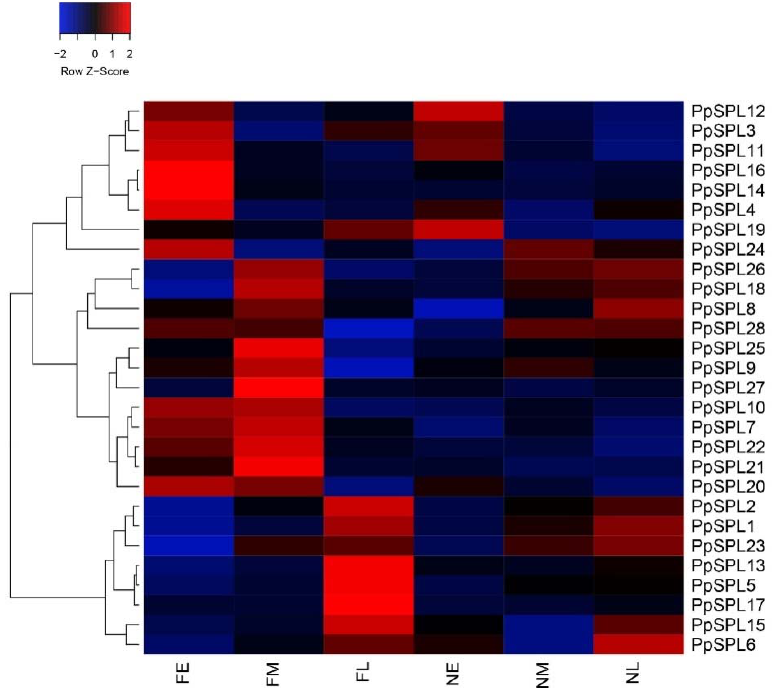
Figure 5. Expression pattern of PpSPLs in the different tissues of flowering Pleioblastus pygmaeus and non-flowering plants. FE, dormant shoot buds from flowering P. pygmaeus ; FM, germinated shoots from flowering P. pygmaeus ; FL, flower buds from flowering P. pygmaeus ; NE, dormant shoot buds from non-flowering P. pygmaeus ; NM, germinated shoots from non-flowering P. pygmaeus ; NL, leaf buds from non-flowering P. pygmaeus .